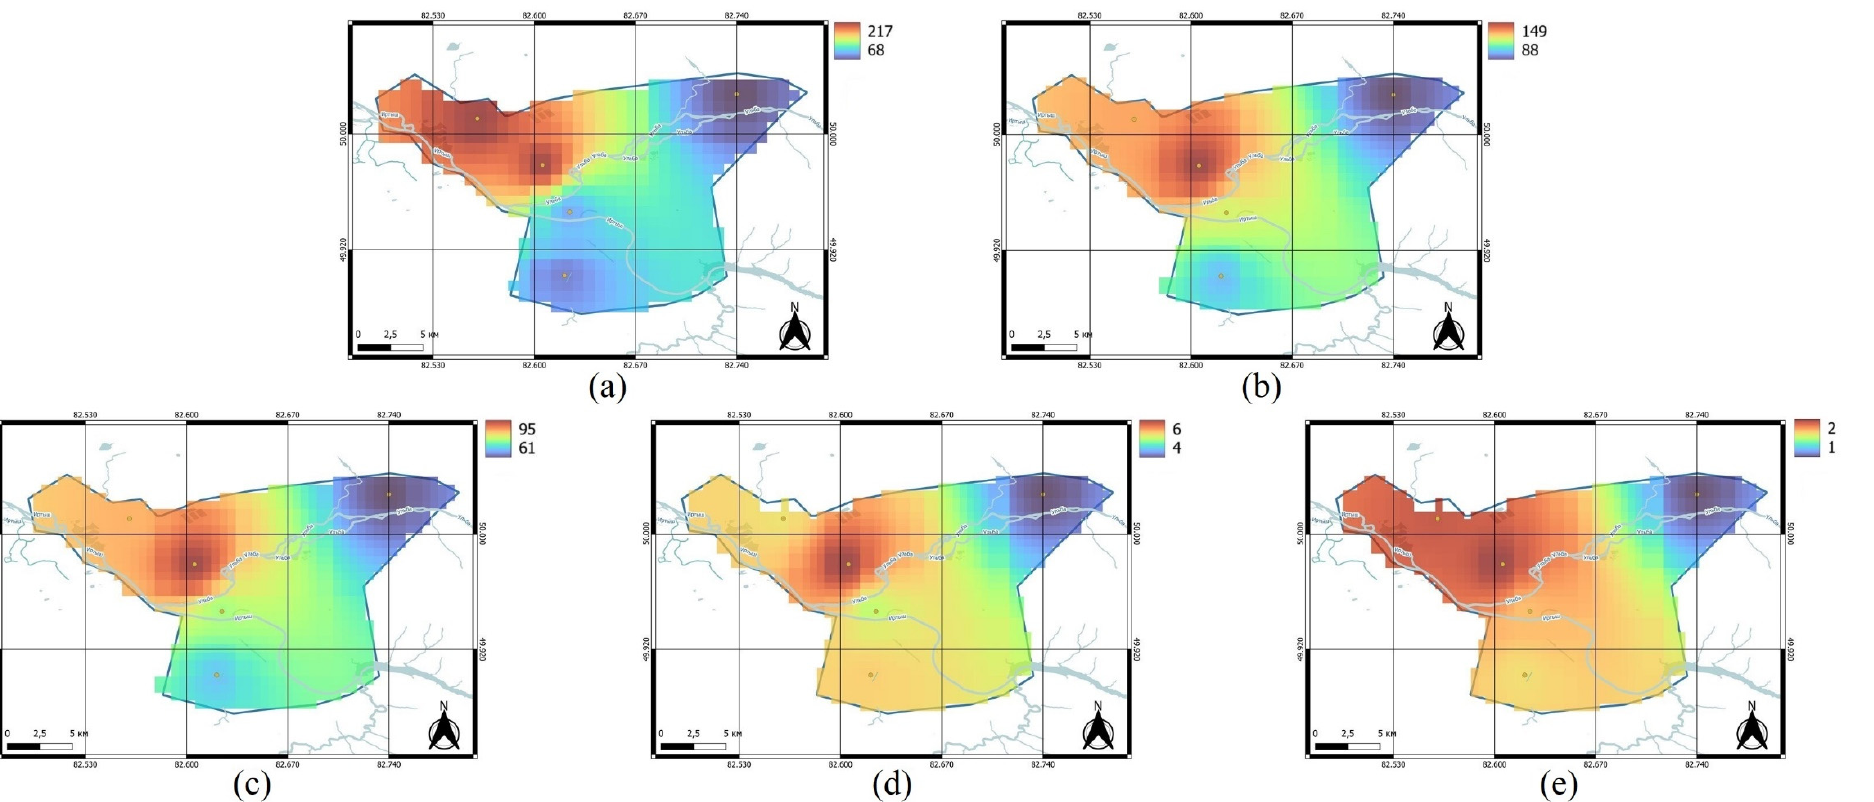
Figure 4. Spatial distribution patterns for ( a ) TSP, ( b ) SO 2 , ( c ) NO 2 , ( d ) HF, and ( e ) formaldehyde during the cold seasons ( μ g m − 3 ).